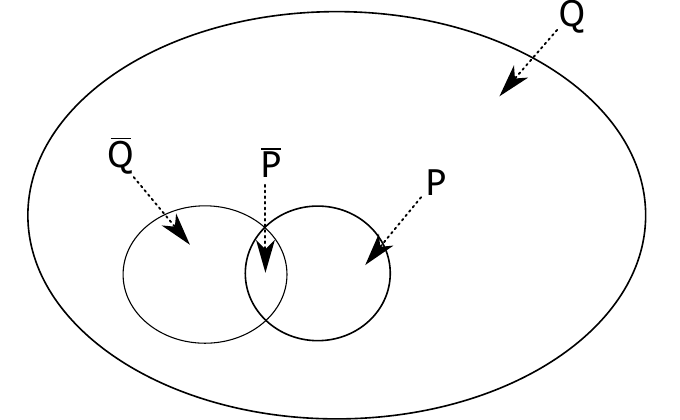
Figure 4. The different sets of queries defined for each dataset.